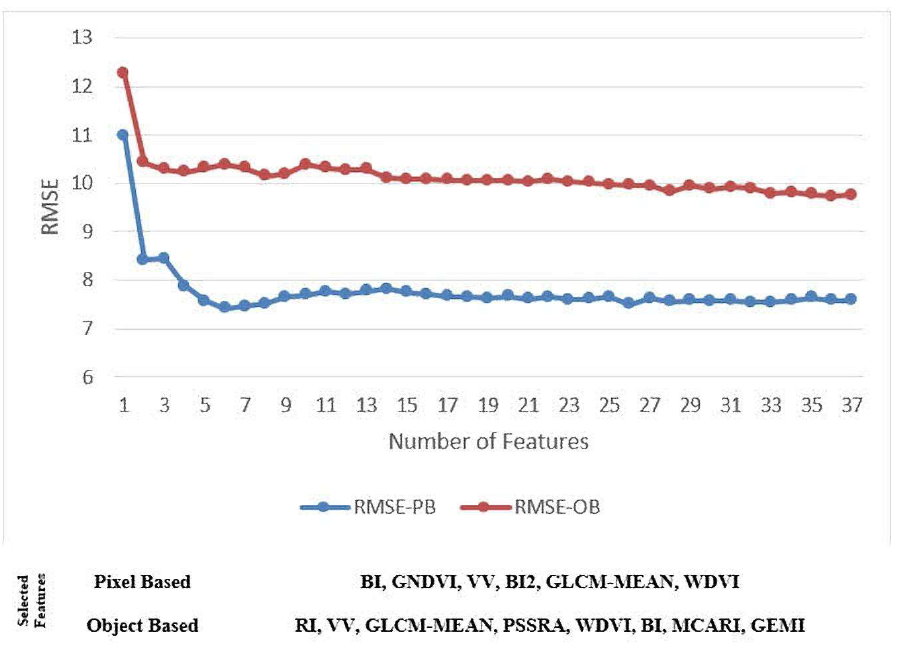
Figure 5. Different feature subset sizes with the corresponding root mean square error (RMSE) and final selected features for both approaches. PB, pixel-based; OB,